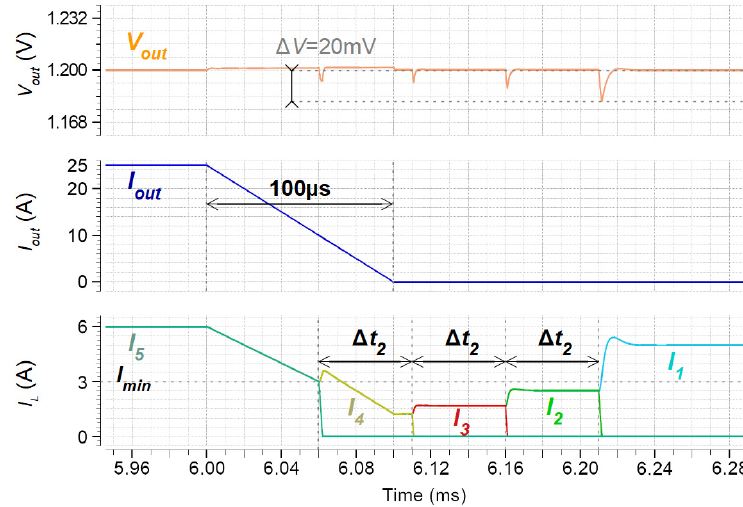
Figure 8. Simulation of the converter response for a fast load transient falling from 25 to 0 A with shutdown preventing delay ( Δ t 2 = 50 μ s).